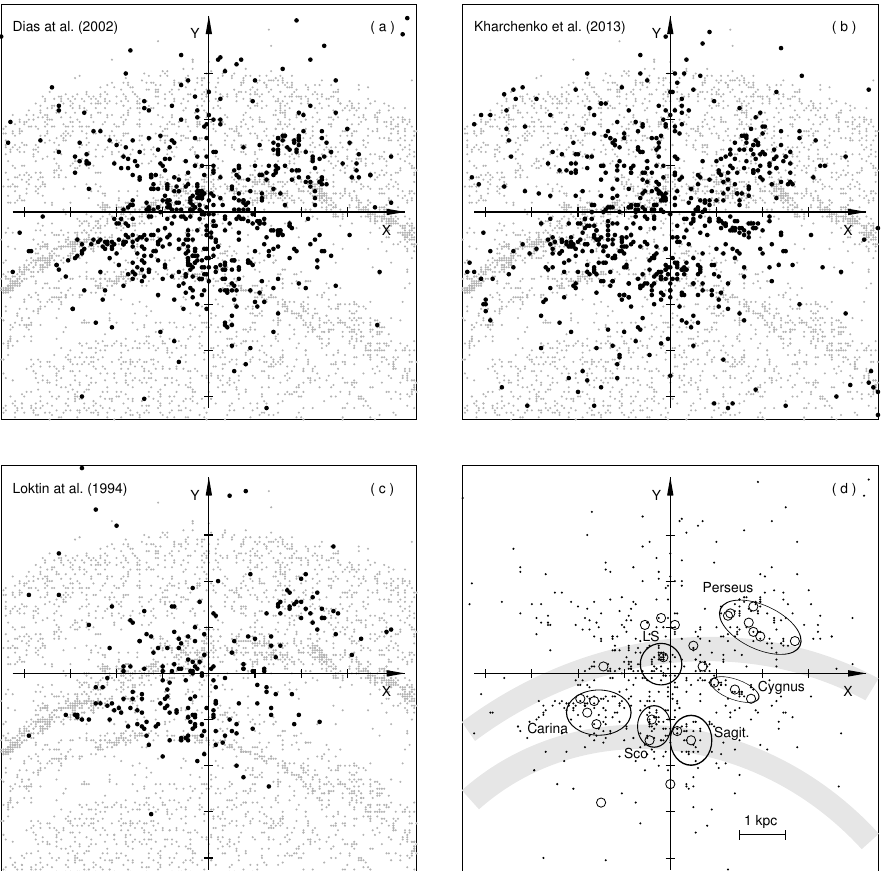
Fig. 1. (a) Distribution of young (log age < 8 : 00) open clusters (black circles) from the catalogue by Dias et al. (2002) and model particles (grey dots) in the Galactic plane. (b, c) Cluster parameters are adopted from the catalogues by Kharchenko et al. (2013) and Loktin et al. (1994), respectively. (d) The distribution of young open clusters from the catalogue by Dias et al. (2002) (black dots) and rich OB-associations (open circles) in the Galactic plane. The locations of the outer rings R 1 and R 2 are indicated by the gray arches. The positions of the Sagittarius, Scorpio, Carina, Cygnus, Local System (LS), and Perseus stellar-gas complexes are drawn by ellipses. The Sagittarius and Scorpio complexes can be associated with the ring R 1 . The Perseus complex and Local System are associated with the ring R 2 . The Carina region lies in-between the two outer rings, where they seem to fuse together. The Sun is at the origin. The positions of model particles are drawn for (cid:18) b = 45 ◦ . The X -axis points in the direction of the Galactic rotation and the Y -axis is directed away from the Galactic